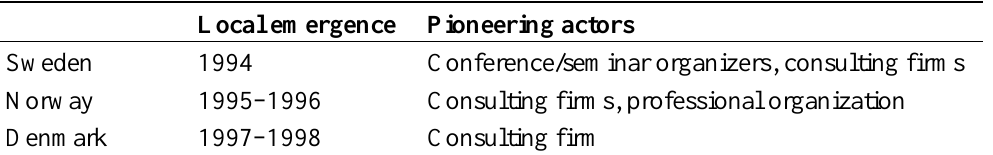
Table 4. The local emergence and pioneering